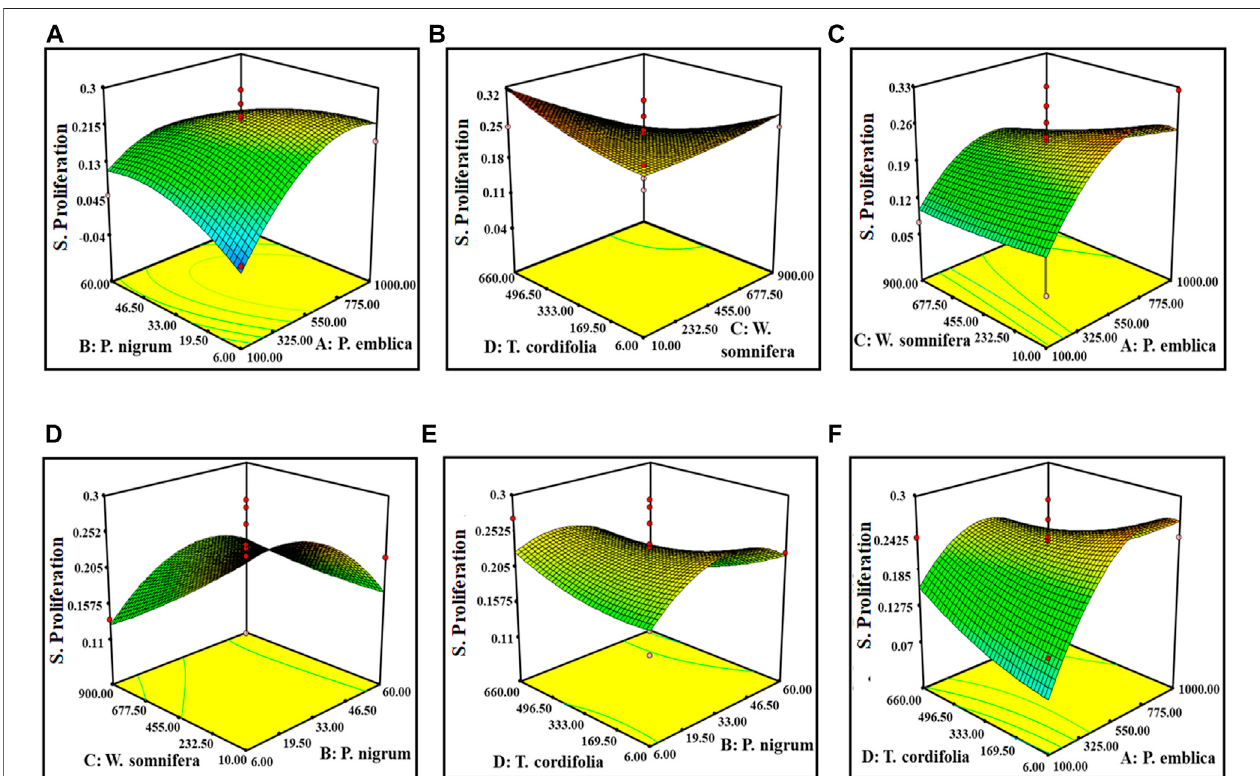
FIGURE 2 | Response surface graph showing the interaction among four extract concentrations and splenocyte proliferation activity. Interaction between (A) P. emblica and P. nigrum , (B) P. emblica and W. somnifera , (C) P. emblica and T. cordifolia , (D) P. nigrum and W. somnifera , (E) P. nigrum and T. cordifolia , and (F) W. somnifera and T. cordifolia